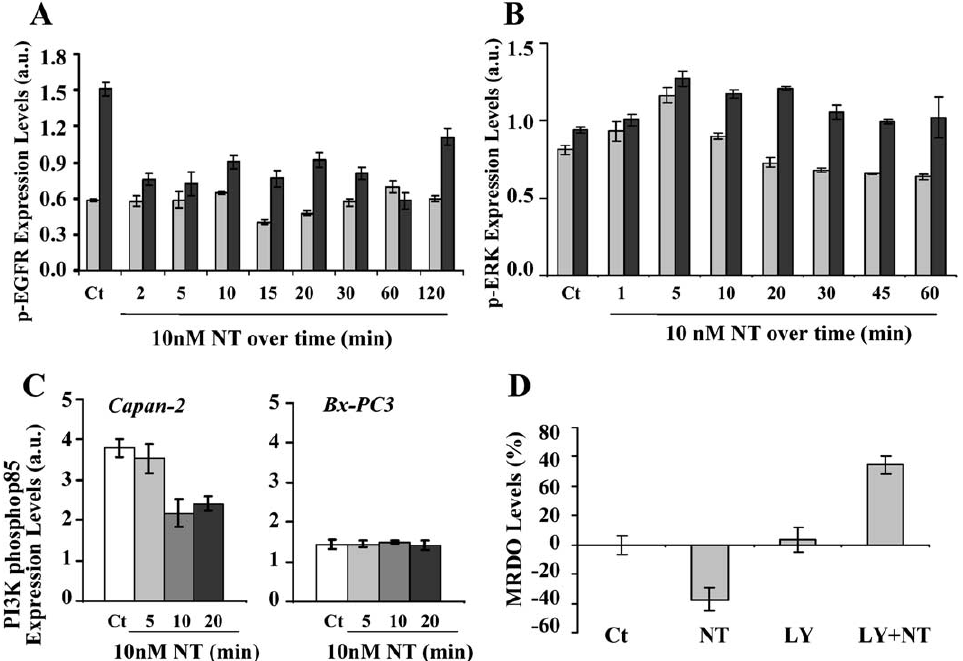
Fig. 3. Characterization of the signaling pathways affected by 10 nM NT in PDACs cultured on vitronectin. Evaluation of the NT effects on the EGFR (A) and ERK (B) phosphorylation levels in Capan-2 and Bx-PC3 (gray and black bars respectively). (C) The NT effects on the levels of expression of phosphorylated p85 PI 3-kinase. (D) The NT effects on the motility levels (expressed with control taken as reference) of Capan-2 cells cultured on vitronectin in the presence and absence of a PI3-K inhibitor (LY-294002; 50 µ M). All the data are expressed as means ±